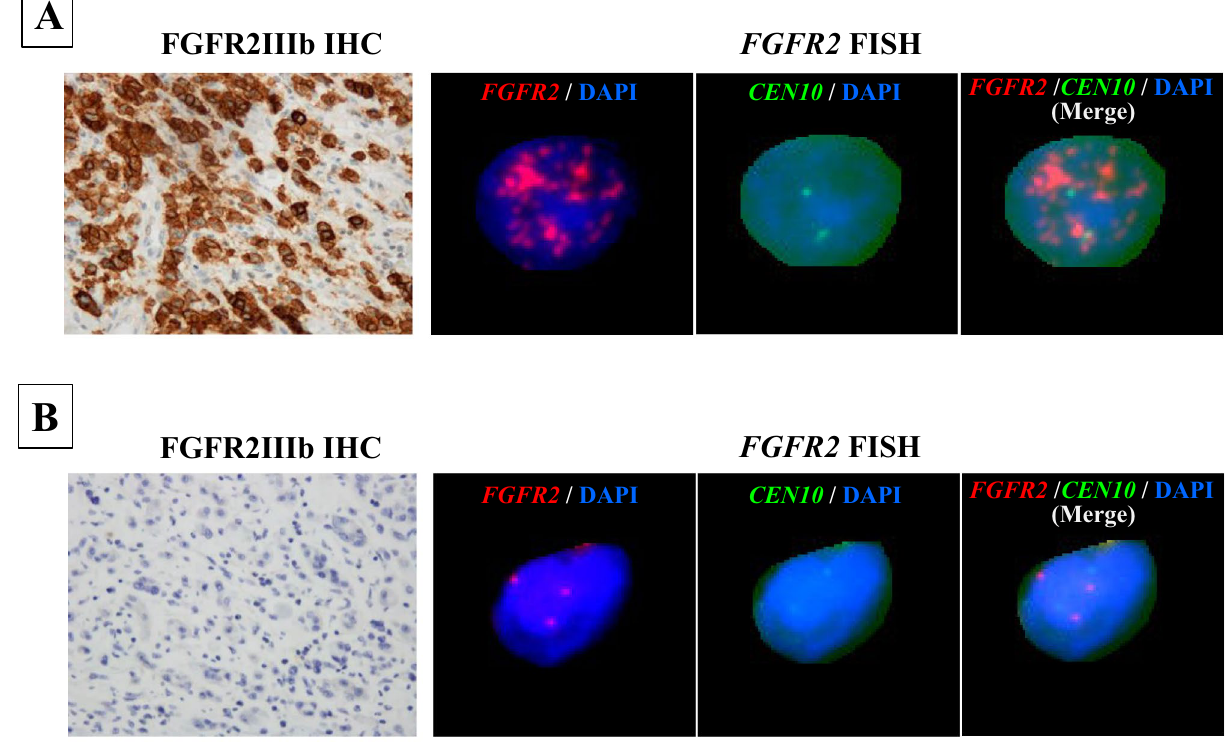
Figure 2. FGFR2 amplification by FISH. ( A ) This sample designated FGFR2IIIb IHC score 3 + showed FGFR2 amplification ( FGFR2/CEN10 ratio = 11.79). ( B) This sample designated FGFR2IIIb IHC score 0 didn’t show